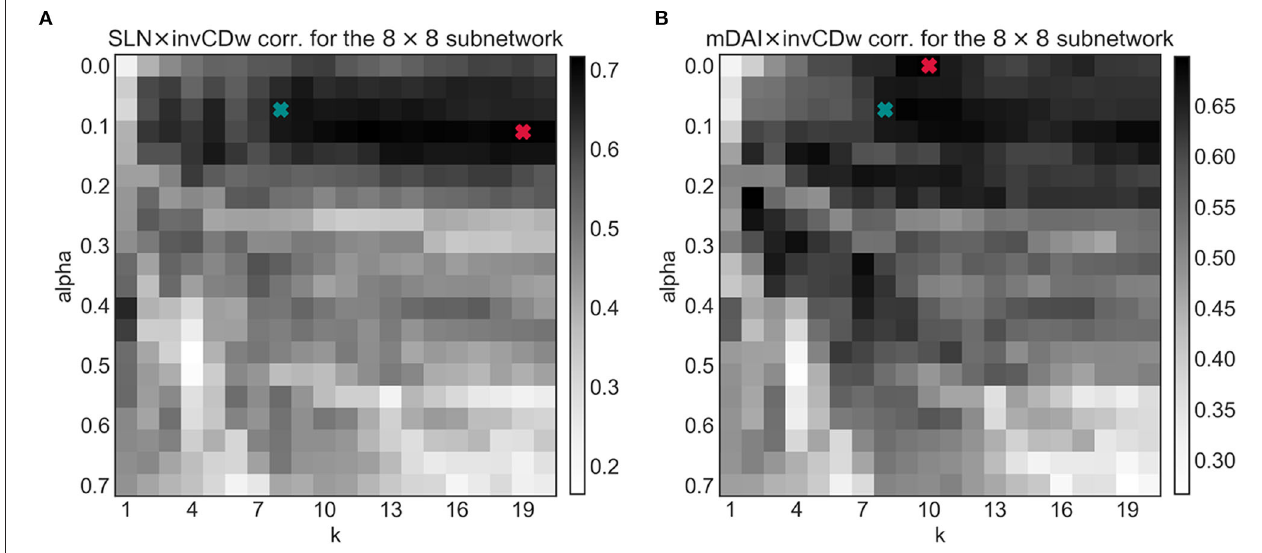
FIGURE 8 | The tuning parameter dependencies of the linear correlations for the invCDw with the SLN (A) and with the mDAI (B) for the 8 × 8 subnetwork. Blue markers show the optimized α and k (see Figure 4 ), while red markers denote the absolute maxima of the 2D arrays. Note that the blue markers fall in the highly optimal regime in both cases. The notations are the same as in the previous